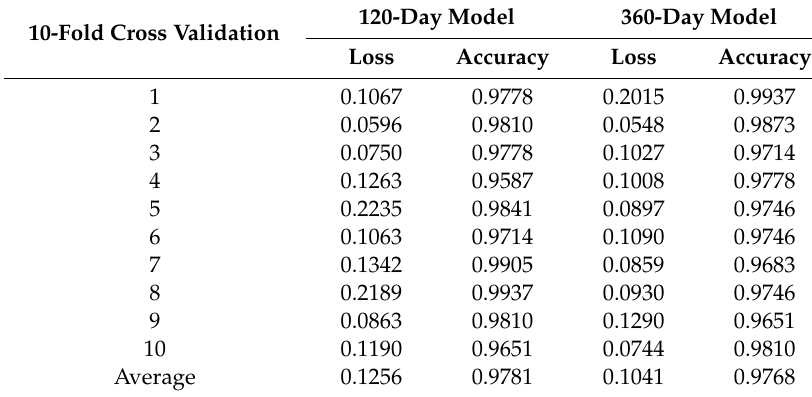
Table 3. 10-fold cross validation of the